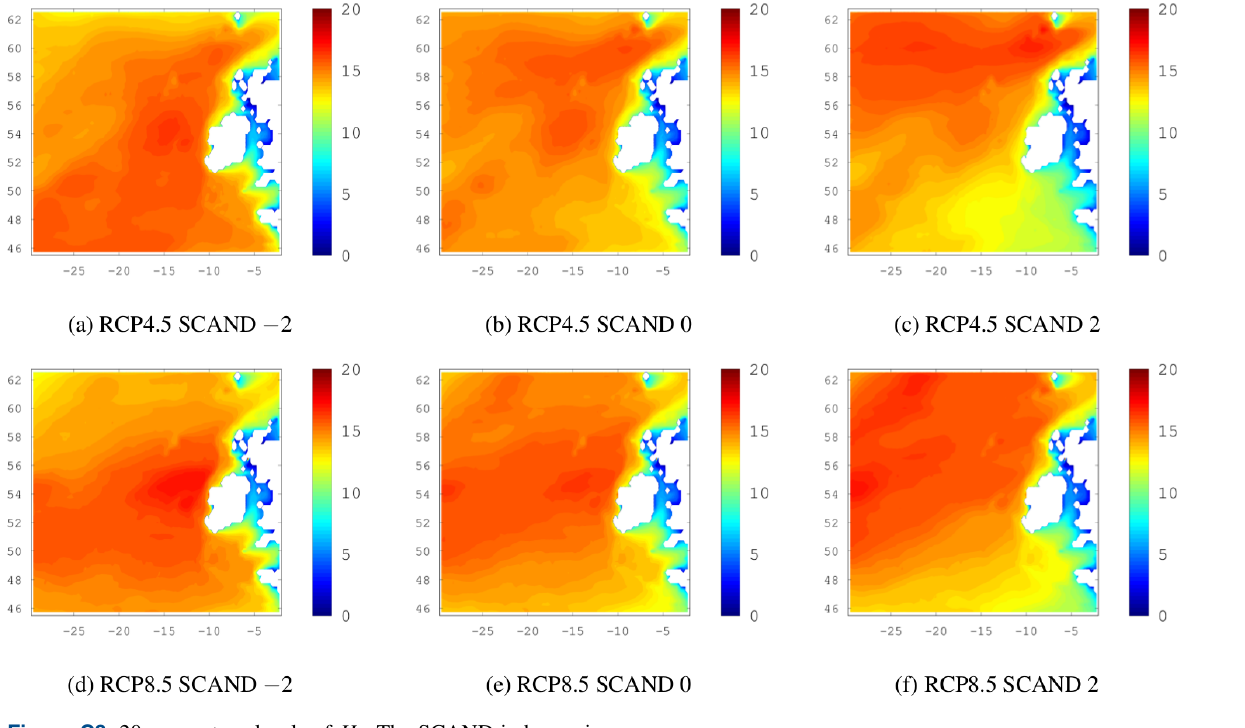
Figure C3. 20-year return levels of H s . The SCAND index varies from 3 values of the NAO index while the NAO and EA are held in their neutral state (zero). The top row shows the ensemble mean for the future period under RCP4.5 and the bottom row is similar but shows RCP8.5